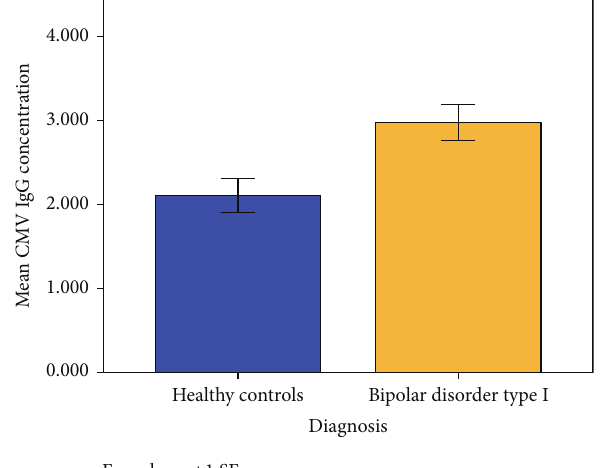
Figure 1: Graphical depiction of diagnostic differences in Cytomegalovirus (CMV) antibody concentrations. Standardized mean antibody (IgG) concentrations are depicted on the vertical, 𝑦 - axis and diagnosis on the horizontal 𝑥 -axis. CMV IgG concentration was higher in BD-I volunteers (shown in maize color) as compared to healthy control volunteers (shown in blue color) (T 234 = 3.1 ; = 0.002 ; 𝑃 = 0.006 ). No diagnostic differences were 𝑃 uncorr corr identified with regard to HSV-1 IgG (T 236 = 0.15 ; 𝑃 = 0.89 ) and HSV-2 IgG (T 236 = 0.14 ; 𝑃 = 0.89 ). Error bars represent ± 1 standard